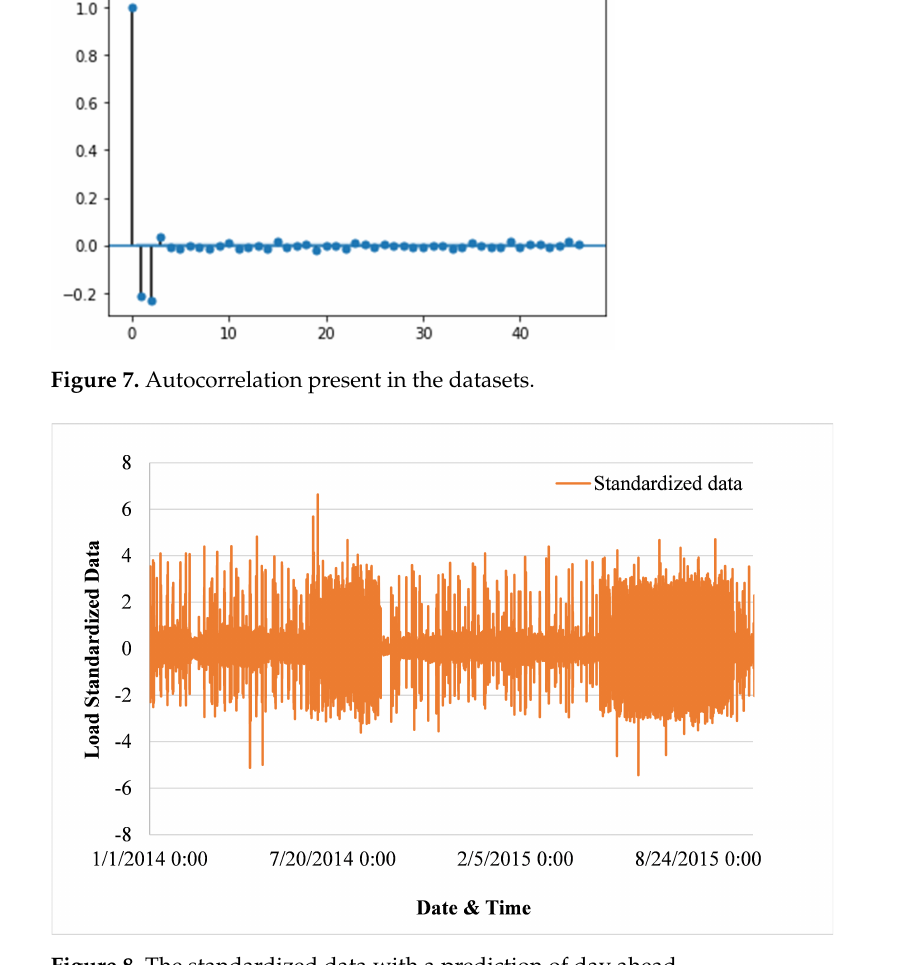
Figure 8. The standardized data with a prediction of day